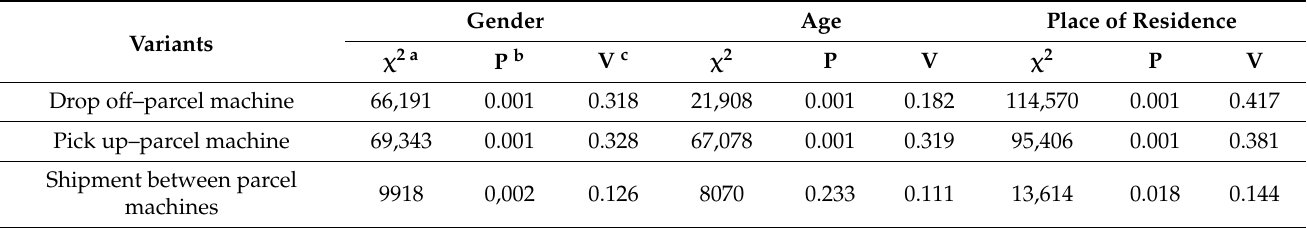
Table 4. Using innovative technological solutions, such as parcel lockers in delivery services at the last-mile stage, in terms of gender, age, and place of residence as represented by the results of a χ 2 independence test with the strength of the relationship determined by V-Cramer.